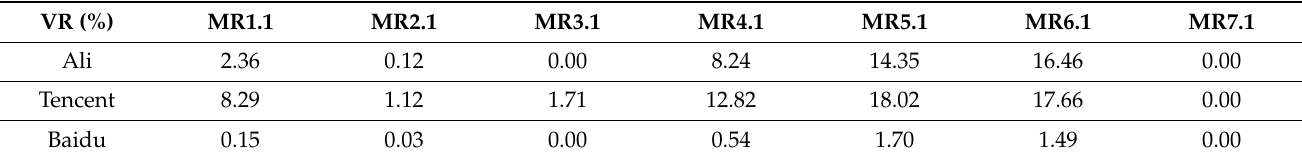
Table 7. Results of text